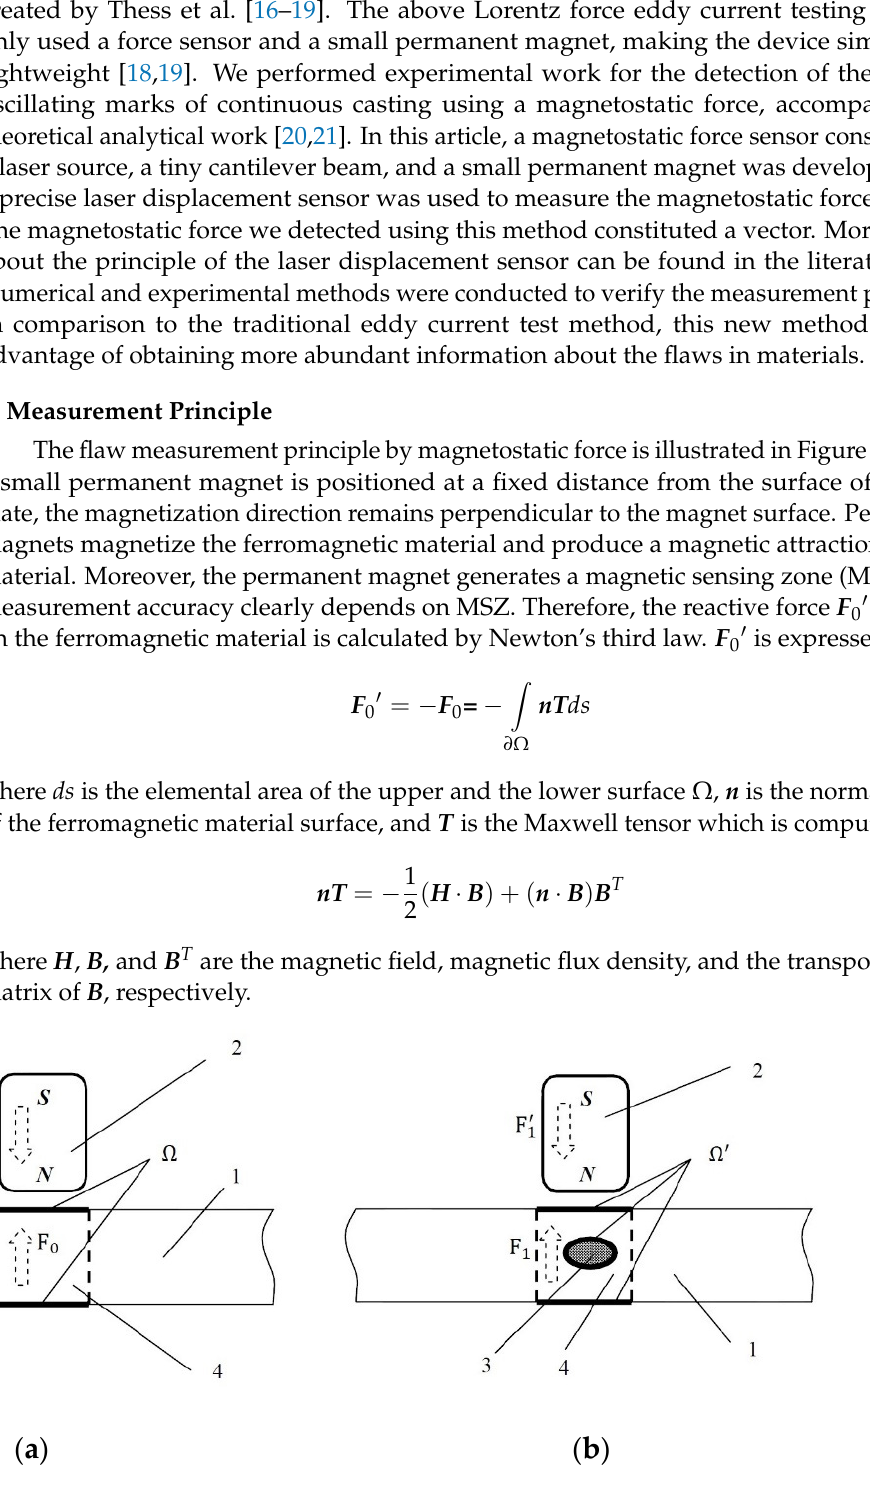
Figure 1. Flaw measurement principle by magnetostatic force: ( a ) Without flaws and ( b ) With a defect. (1—sample, 2—permanent magnet, 3—flaw, 4—magnetic sensing zone. Ω is the surface and Ω′ is the interface.).